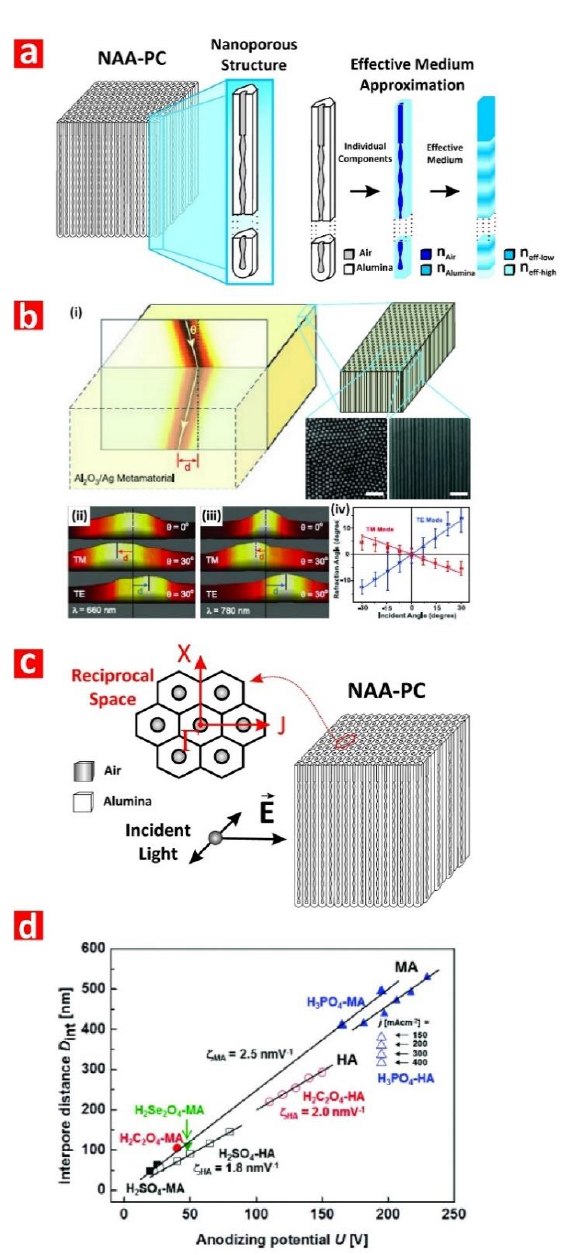
Figure 5. Intrinsic relationship between nanoporous geometry and optical properties in nanoporous anodic alumina photonic crystals (NAA-PCs). ( a ) Structural engineering of effective medium of NAA-PCs with details of the intrinsic relationship between nanoporous geometry and effective medium approximation. ( b ) NAA-PC as a metamaterial platform with negative refraction of light (reproduced from [45], with copyright permission from The American Association for the Advancement of Science, 2008). ( i ) Illustration showing negative refraction from air into composite NAA-PC filled with silver nanowires ( left ) and schemed showing the structure of the composite NAA-PC-Ag nanowires and SEM images of these photonic structures (scale bars = 500 nm); ( ii ) and ( iii ) beam intensities at the surface of the composite NAA-PC-Ag nanowires at 660 and 780 nm, respectively; ( iv ) dependence of refraction angles on incident angles and polarizations at 780 nm wavelength. ( c ) Schematic showing the structure of a 2D NAA-PC with incident light flowing perpendicularly to its nanopores. ( d ) Self-ordering regimes in MA (filled symbols) and HA (open symbols) in the most representative acid electrolytes used to produce NAA. Reproduced from [28], with copyright permission from American Chemical Society, 2014.